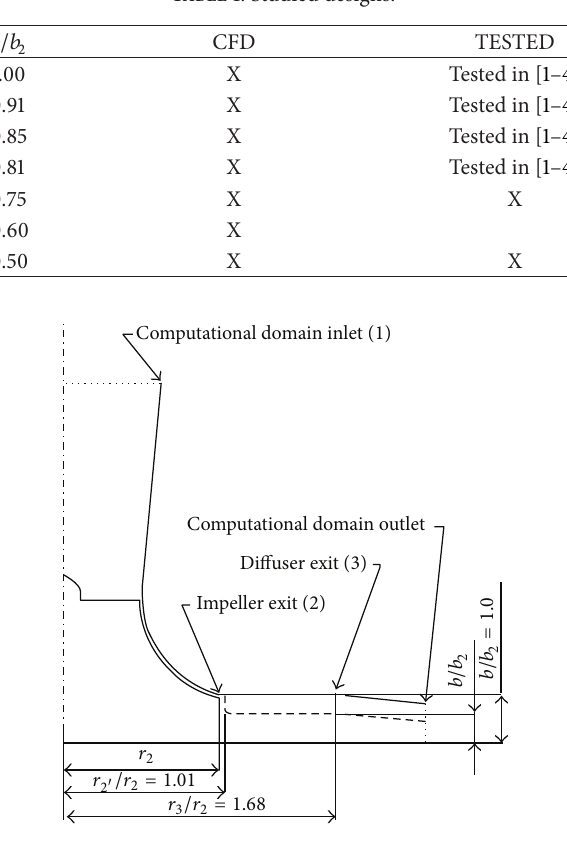
Figure 1: Schematics of the design, showing the unpinched (solid line) and pinched (dashed line) designs.